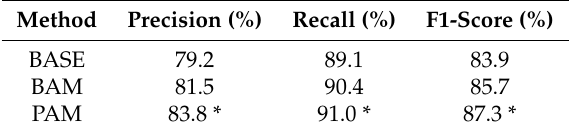
Table 4. Ablation study of attention modules on LEVIR-CD test